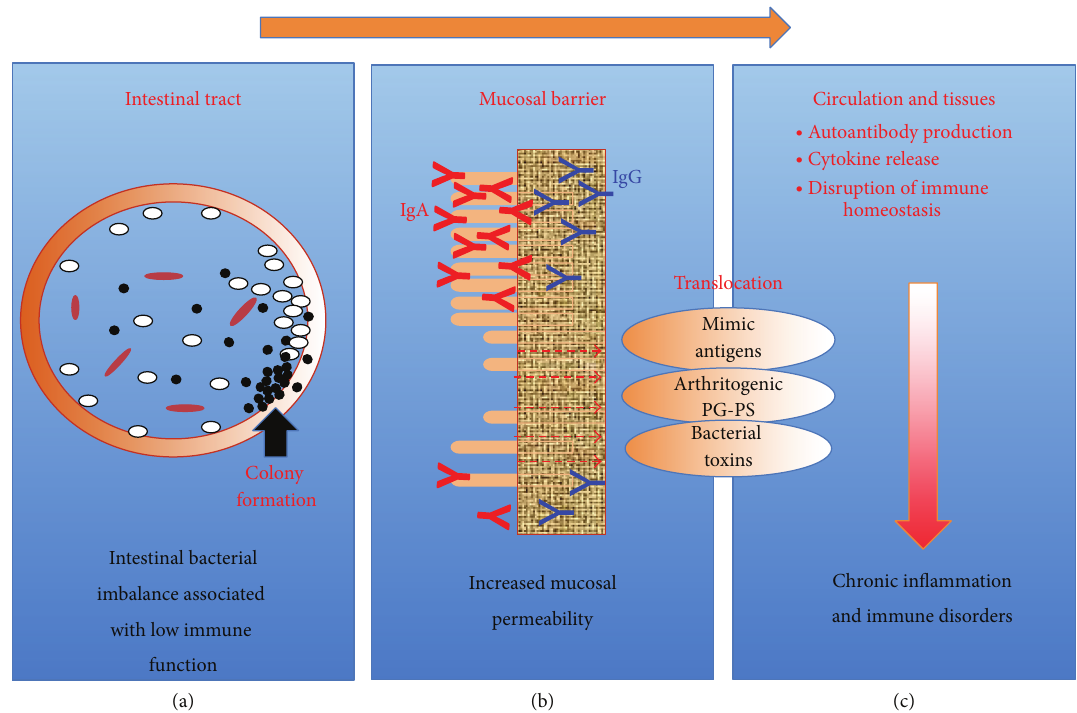
Figure 5: Possible contribution of pathogenic and nonpathogenic environmental factors to autoimmune diseases: low immune function may lead to intestinal bacterial imbalance by failing to prevent the colony formation of pathogenic bacteria (a). In addition decreases in the mucosal barrier function result in increased intestinal mucosal permeability (b). As a result, excess amounts of bacterial components and their toxins and even large molecular, undigested dietary proteins, which share similar amino acid sequences with autologous components such as collagen, cross the mucosal barrier into circulation (c). Some of these exogenous substances can disturb immune homeostasis and result in the development of chronic